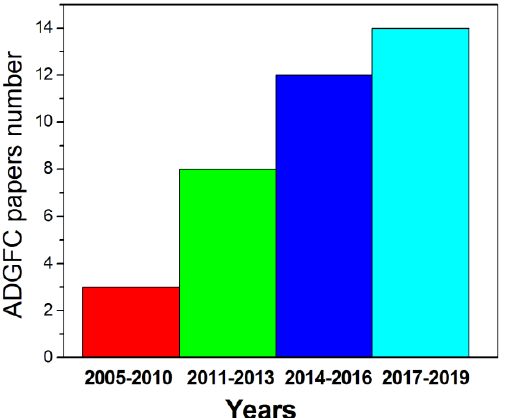
Figure 6. Histogram of paper numbers devoted to alkaline direct glycerol fuel cells (ADGFCs) per group of years.